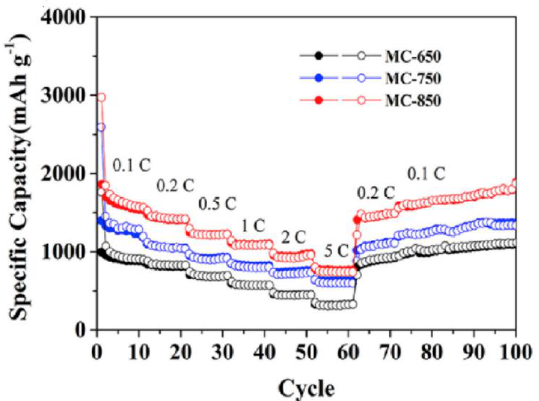
Figure 5. Cyclic performance of self-doped graphene nanosheets produced through magnesiothermic reduction of melamine at 650 °C (black curve), 750 °C (blue curve) and 850 °C (red curve). Reproduced, adapted and reprinted with permission from Reference [84].